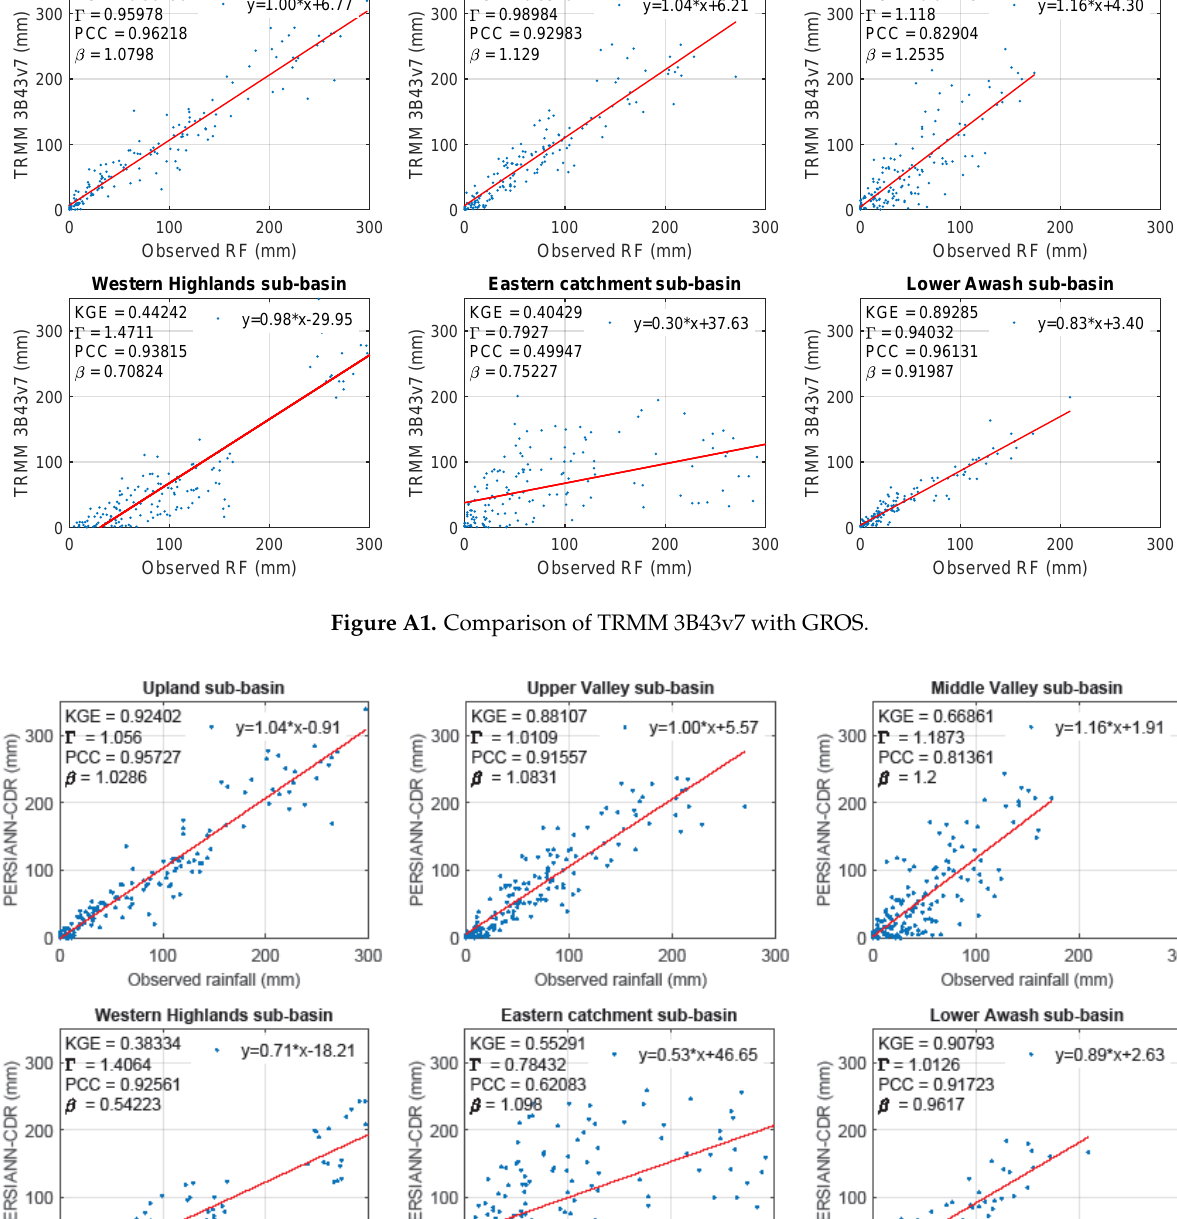
Figure A3. Comparison of IMERG with GROS.